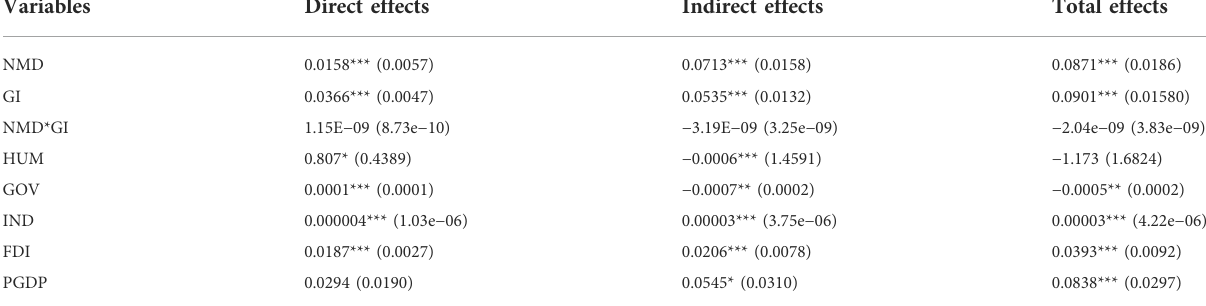
TABLE 5 Decomposition of spatial